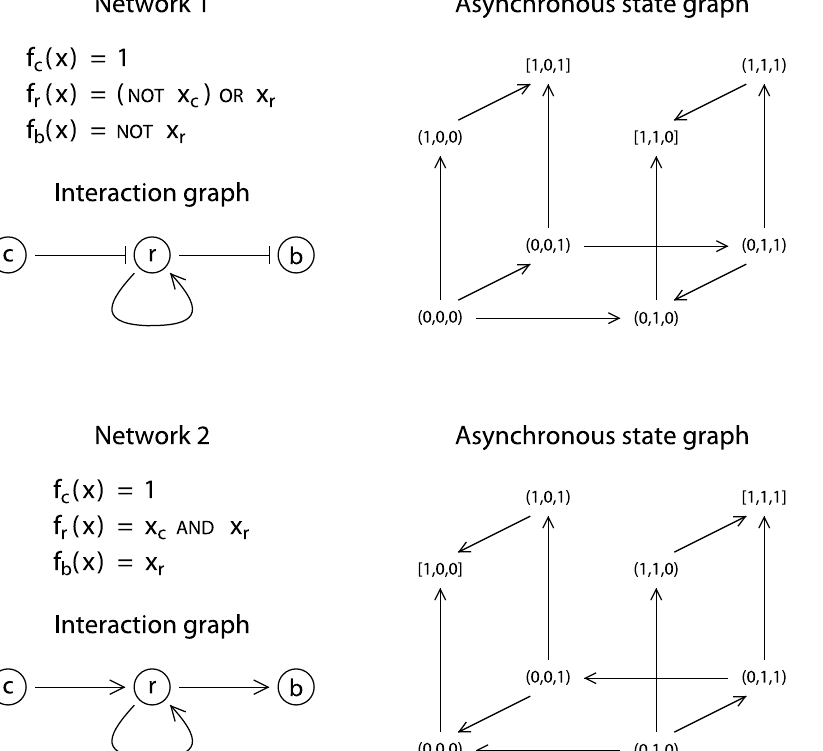
Figure 1. The two minimal consistent Boolean networks with 3 components. The graphical conventions used to described the interaction graph of each network are as follows: normal arrows correspond to positive interactions, and T-end arrows correspond to negative interactions. Asynchronous state graphs are represented in a 3D-grid, with c in the vertical axis (first component), r in the horizontal axis (second component), and b in the third axis (third component).